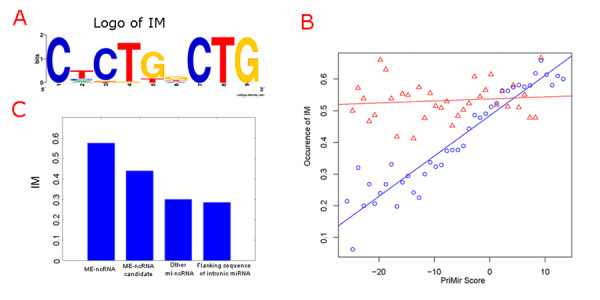
The internal motif (IM) of the me-ncRNAs. A: Logo of the IM (WebLogo [52]). B: The relationship between IM frequency and PriMir Score. The ml-ncRNAs were binned according to their PriMir score, and the fraction of transcripts with the IM were plotted. Blue circles: All ml-ncRNAs. Red triangles: ml-ncRNAs with conserved stem-loops. C: Frequency of IM in experimentally supported me-ncRNAs, unsupported ME-ncRNA candidates, other ml-ncRNAs, and in flanking sequence of intronic miRNAs.